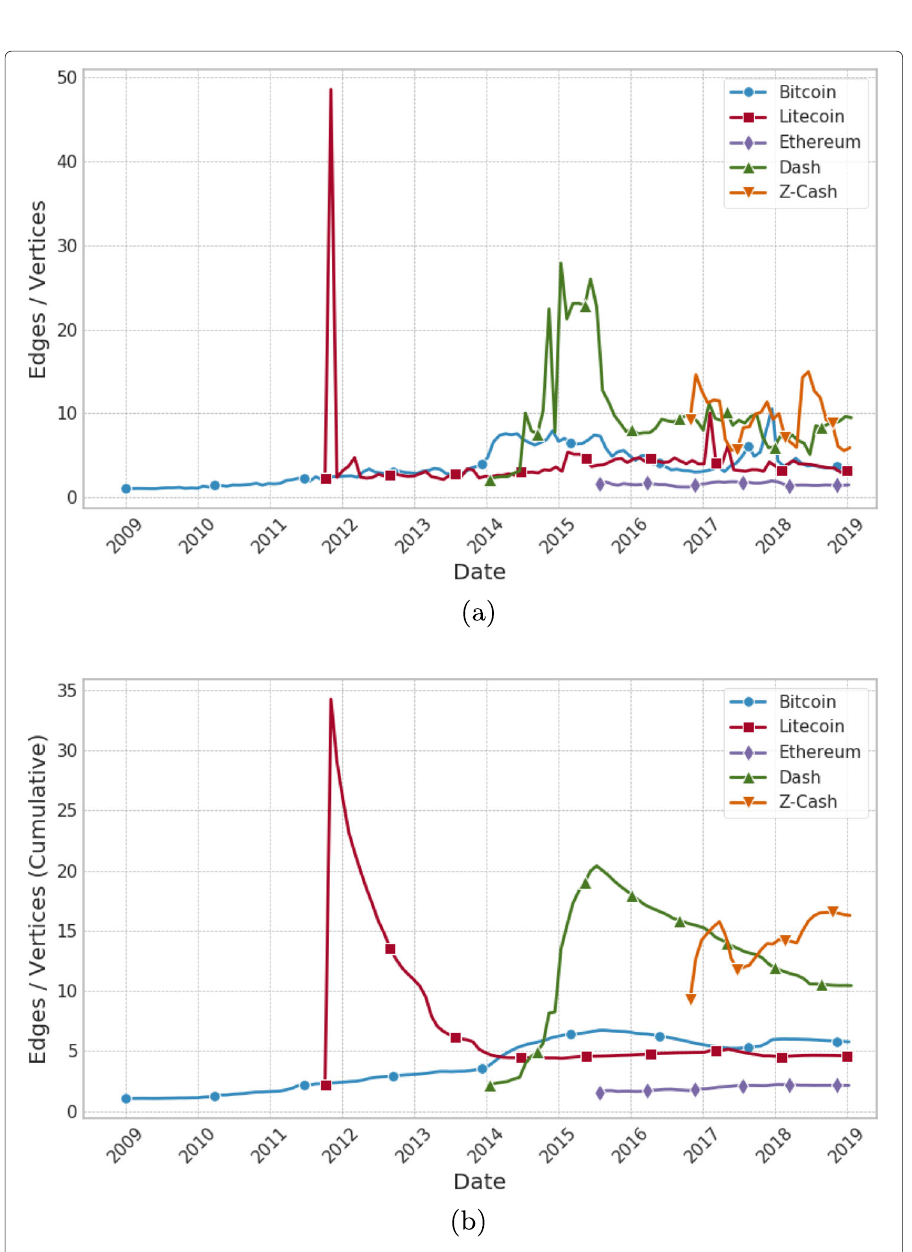
Fig. 6 Edge-to-vertex ratio of transaction graphs. a Timeseries of edge-to-vertex ratio for MTG. b Timeseries of edge-to-vertex ratio for